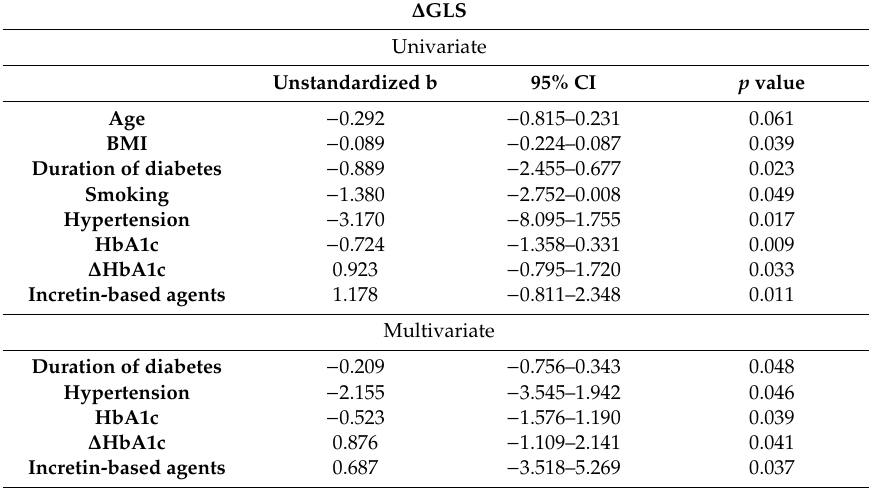
Table 3. Association of the changes of LV myocardial strain, as well as arterial and endothelial markers, with parameters of the study